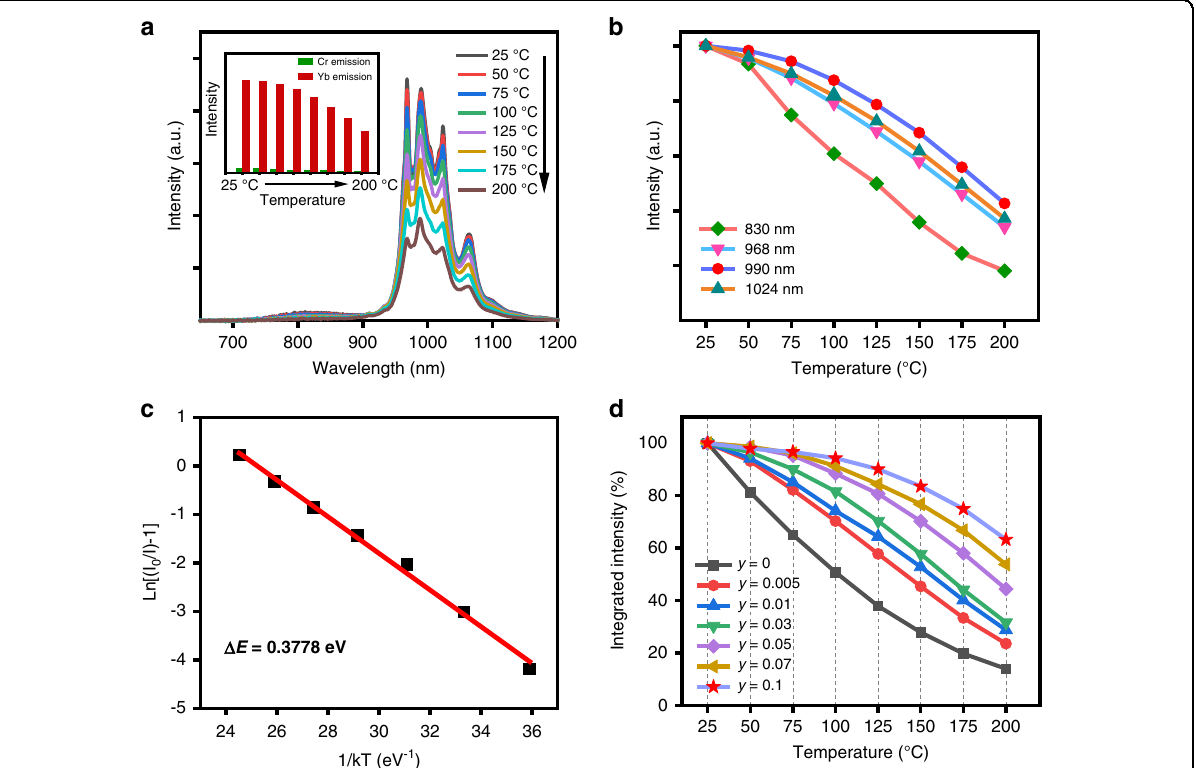
Fig. 4 Temperature-dependent photoluminescence properties of Lu 0.2 Sc 0.8 BO 3 :Cr 3 + ,Yb 3 + phosphors. a Emission spectra of Lu 0.2 Sc 0.8 BO 3 :2% Cr 3 + ,5%Yb 3 + at different temperature. Inset: variation of the Cr 3 + emission intensity and Yb 3 + emission intensity. b The peak wavelength intensities (830, 968, 990, and 1024 nm) of Lu 0.2 Sc 0.8 BO 3 :2%Cr 3 + ,5%Yb 3 + at varied temperature. c The fi tting drawn in Ln( I / I 0 -1) versus 1/ kT coordinates. d Dependence of integrated luminescence intensity on the test temperature with varying Yb 3 + -doping